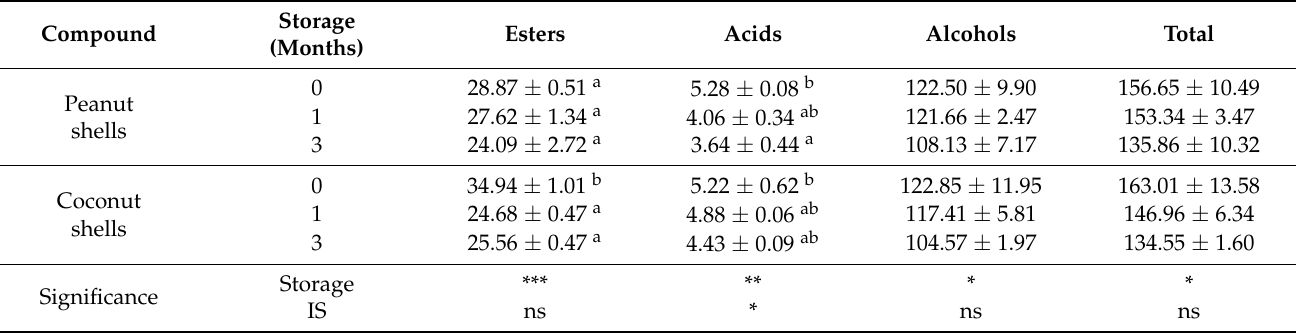
Table 4. Effect of storage of thermally dried immobilized S. cerevisiae on peanut shells and coconut shells on volatile compounds (mg L − 1 ) of